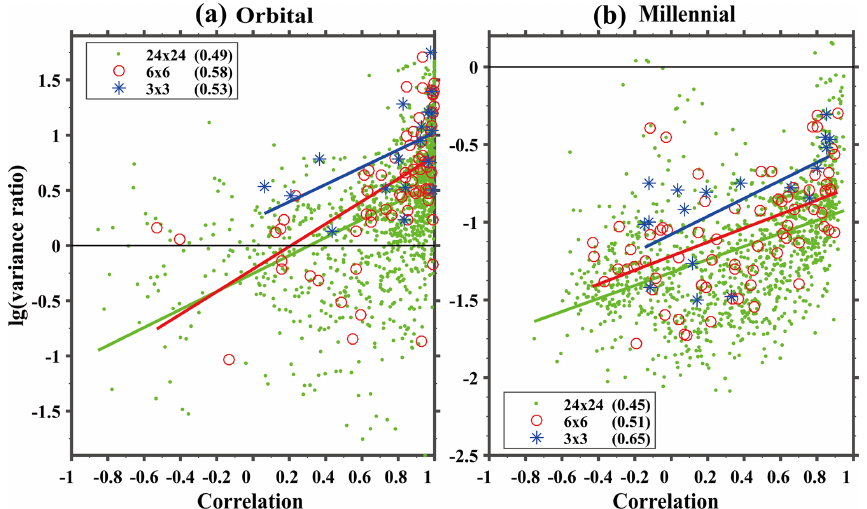
Figure 7. Scatter diagram of the correlation coefficient and the signal-to-noise ratio (variance ratio) on the orbital (a) and millennial (b) timescale. The log base 10 is taken on the variance ratio, as indicated in Fig. 6. Only the three representative spatial factors ( f = 3, 6 and 24) are shown in the panels. The blue stars and linear fitting line are for factor 3; the red circles and linear fitting line are for factor 6; the green dots and linear fitting line are for factor 24. The fitting coefficients are listed in the brackets at the upper left corners of (a) in the lower left corner of (b)